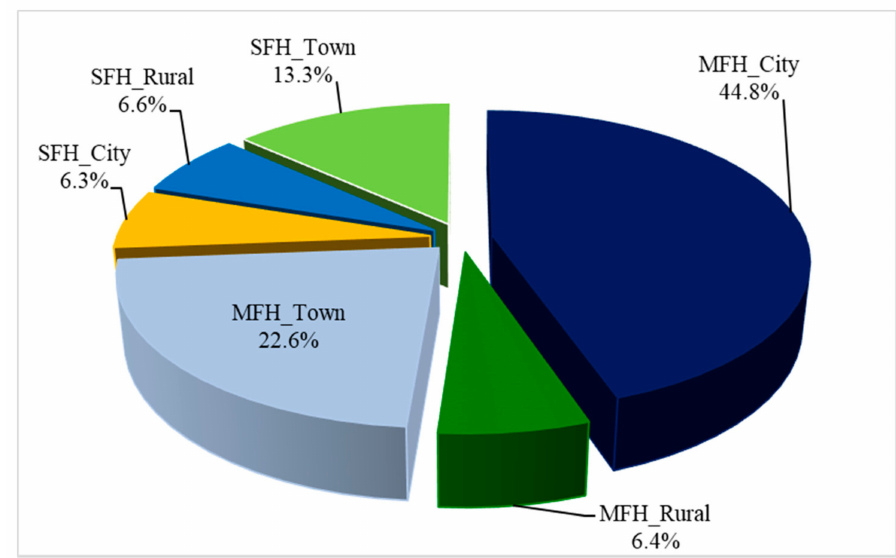
Figure 1. Breakdown of the Italian residential building stock in 2010 (Own elaboration from Eurostat Database [23] and ODYSSEE-MURE Project: https://www.odyssee-mure.eu/publications/efficiency-trends-policies-profiles/italy-italian. html, accessed on 29 May